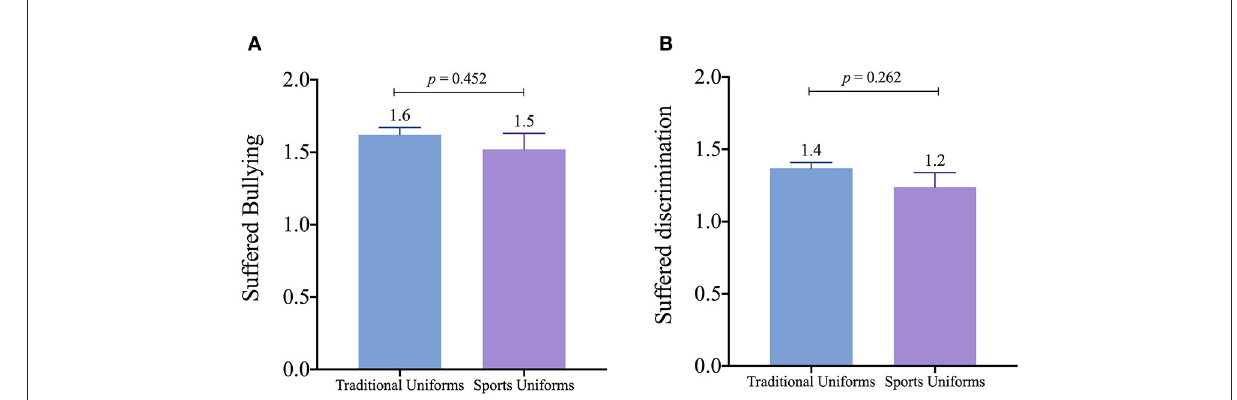
FIGURE3 Bullying and discrimination feelings of adolescents according to uniform types. Estimated marginal means and standard error. Figure according to model 2 (adjusted for sex, PHV, BMIz, physical fitness, and